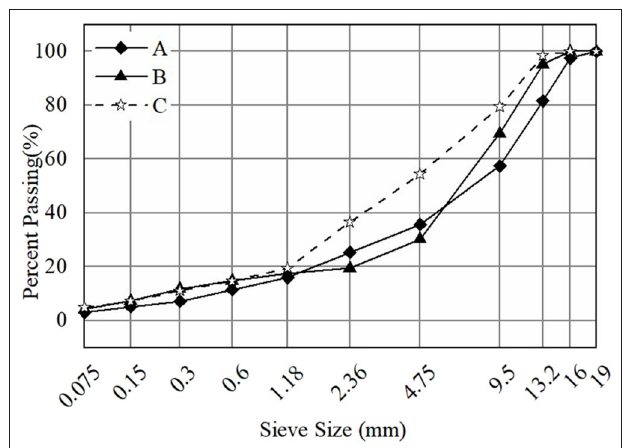
FIGURE 1 | Aggregate gradation for